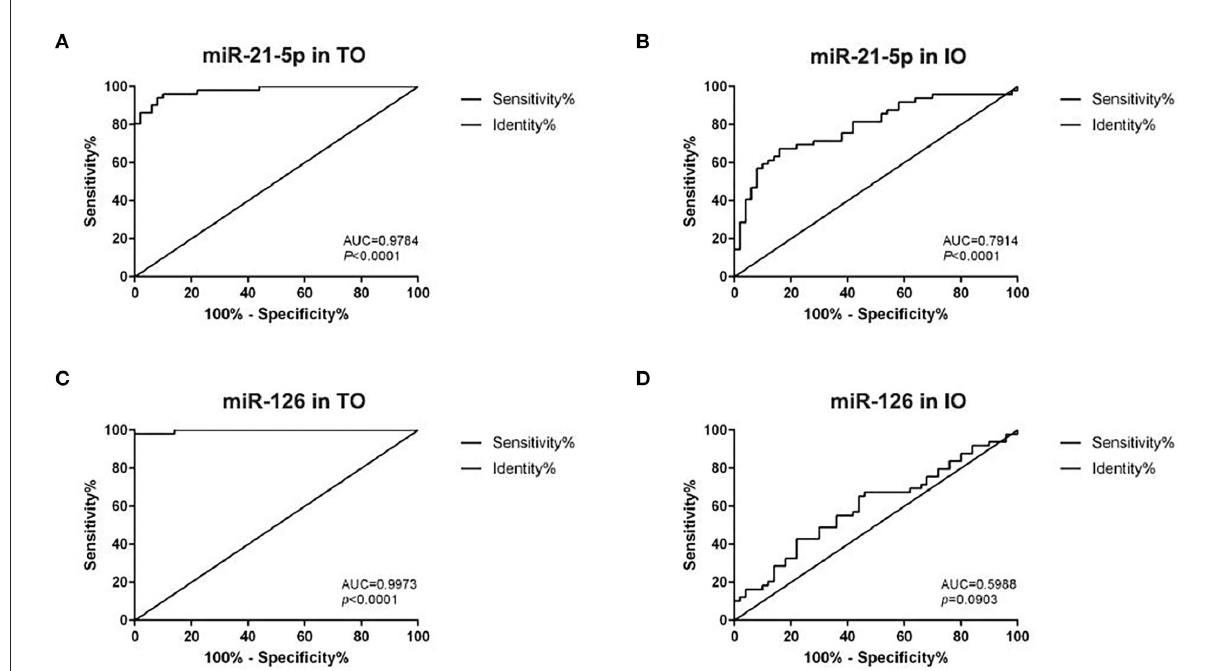
FIGURE4 Receiver operating characteristic analysis of miR-21-5p and miR-126. The areas under the curves are 0.9784 (95% CI: 0.9558–1.001, p < 0.0001) for miR-21-5p in the infarct-related artery total occlusion (IR-ATO) acute myocardial infarction (AMI) group, (A) 0.7914 (95% CI: 0.7014–0.8814, p < 0.0001) for miR-21-5p in the IR blood-vessel recanalization (BVR) AMI group, (B) 0.9973 (95% confidence interval [CI]: 0.9913–1.003, p < 0.0001) for miR-126 in the IR-ATO AMI group, (C) 0.5988 (95% CI: 0.4866–0.7110, p = 0.0903) for miR-126 in the IR-BVR AMI group, and (D) VO = IR-ATO group, and VIO = IR-BVR